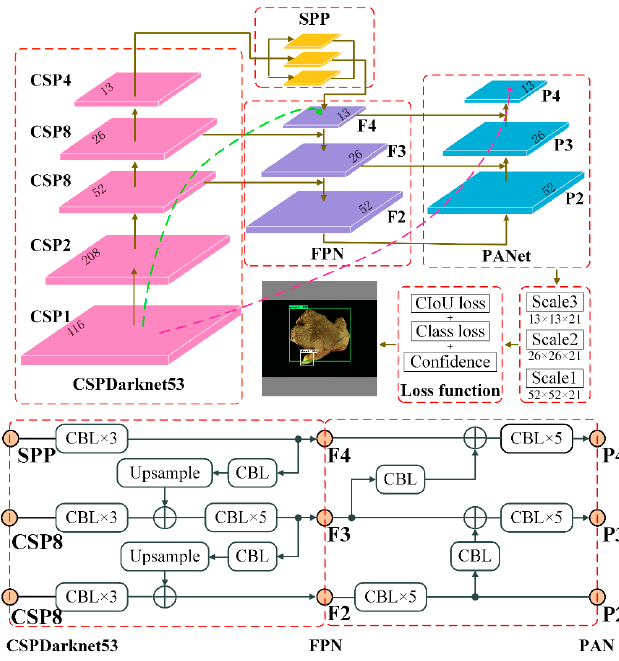
Figure 2. Overview of YOLOv4 network.